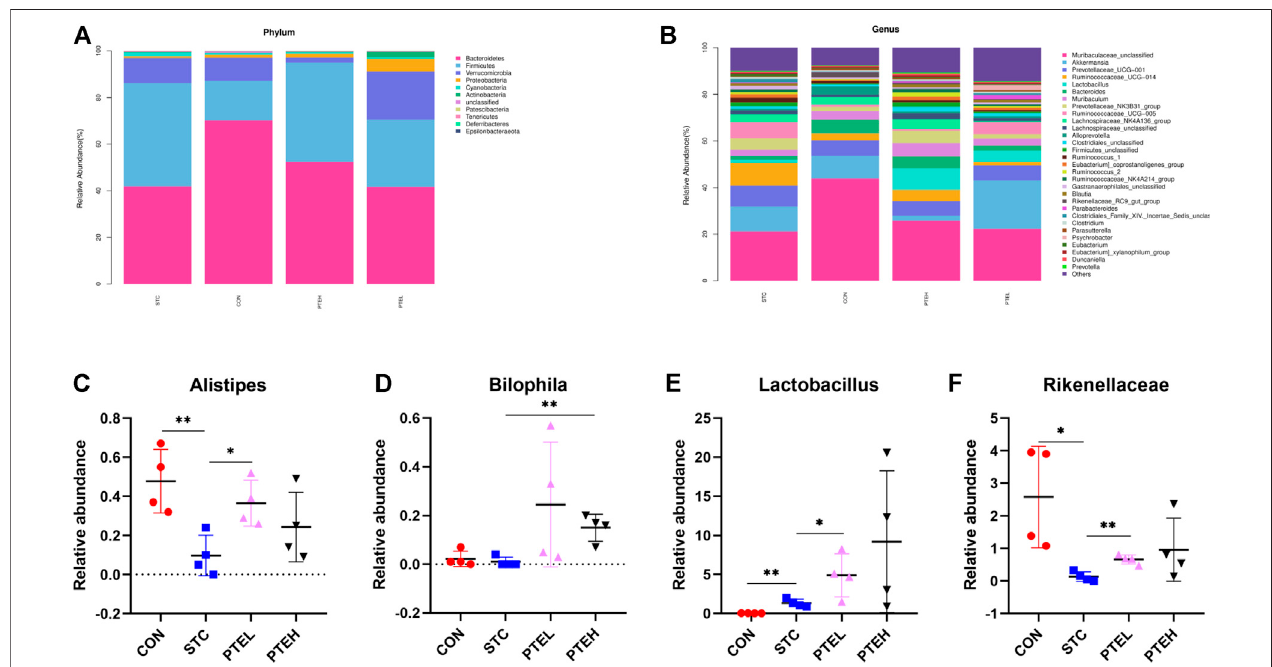
FIGURE 10 | The taxonomic composition of gut microbiota in mouse feces between different groups. (A,B) Relative abundance of microbial communities. (C – F) Relative abundance of main genus in different groups: (C) Alipipes; (D) Bilophila; (E) Lactobacillus; (F) Rikenellaceae. ( n = 4). * p < 0.05, ** p < 0.01.